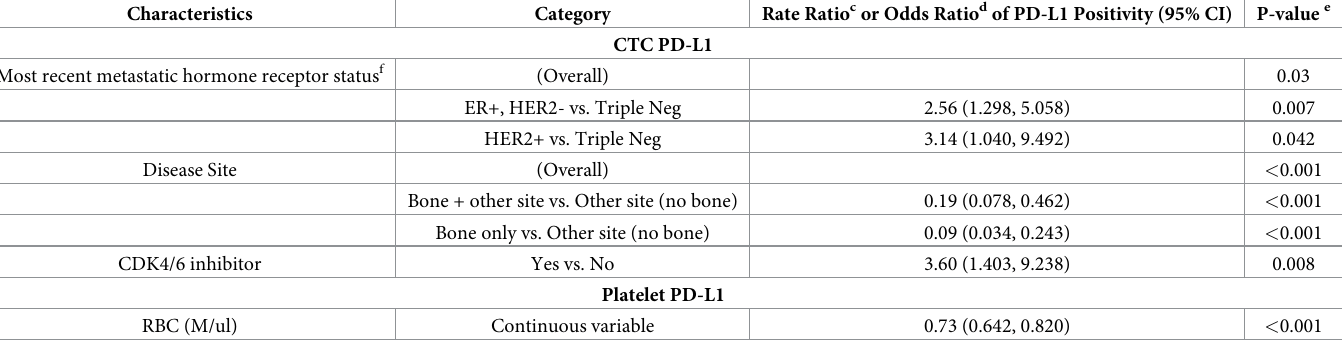
Table 4. Multivariable results of factors of interest with CTC PD-L1 positive rate a and Platelet PD-L1 positivity b .